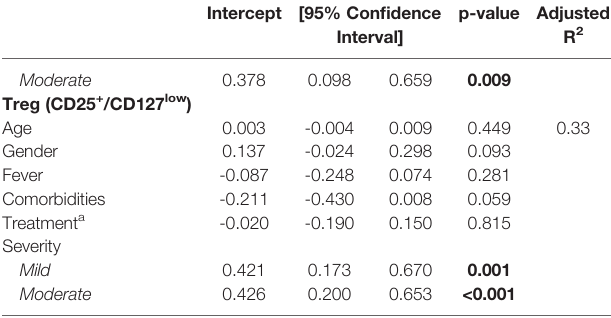
TABLE 3 | Multivariable linear regression analysis.